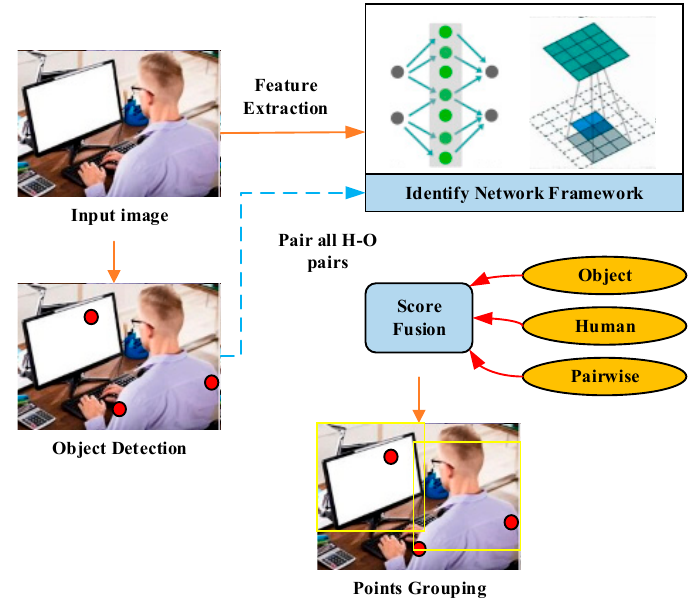
Figure 5. Image-based human interaction detection framework.